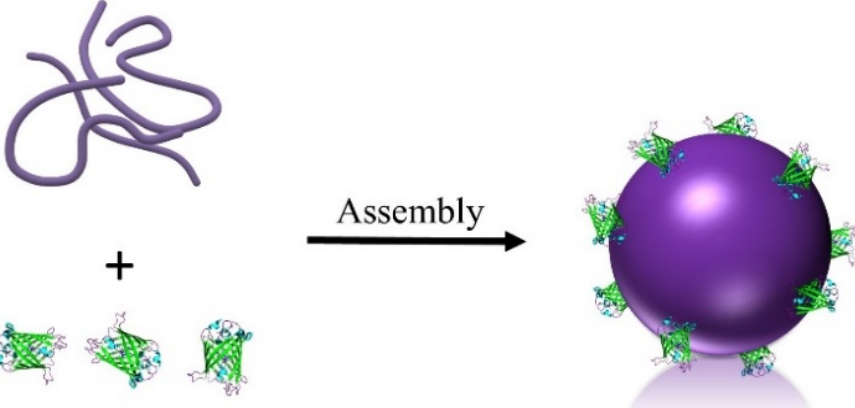
Figure 1. Schematic illustration of the formation of the polymer–protein core–shell nanoparticles (CSNPs).